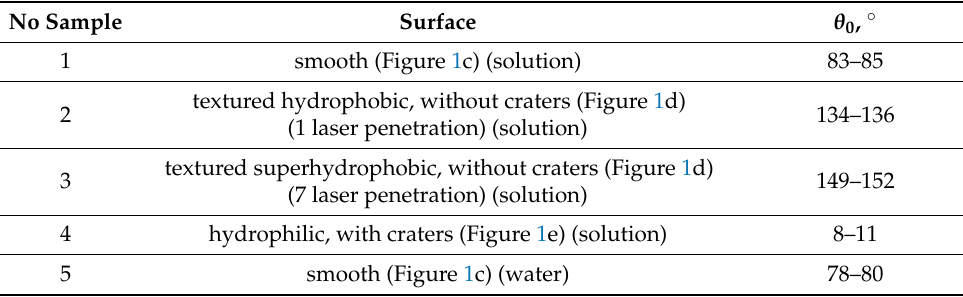
Table 1. Static contact angles of water droplets for various